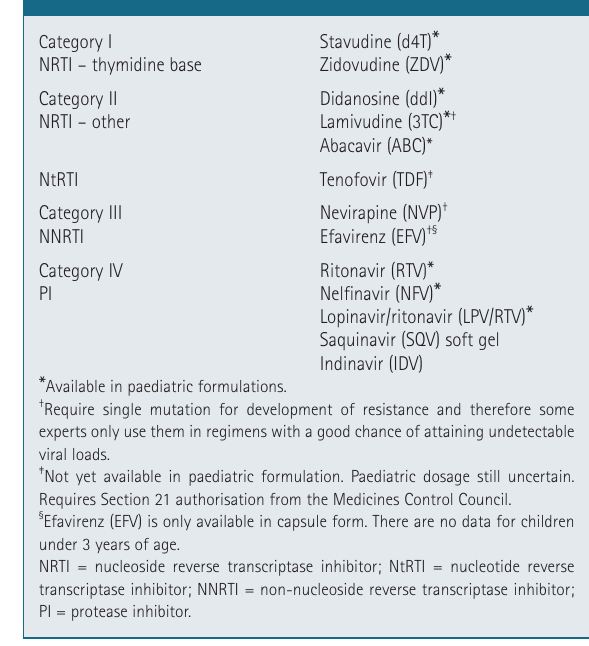
TABLE VII. NATIONAL DOH ART DRUG CHOICES FOR CHILDREN TABLE IV. ANTIRETROVIRAL